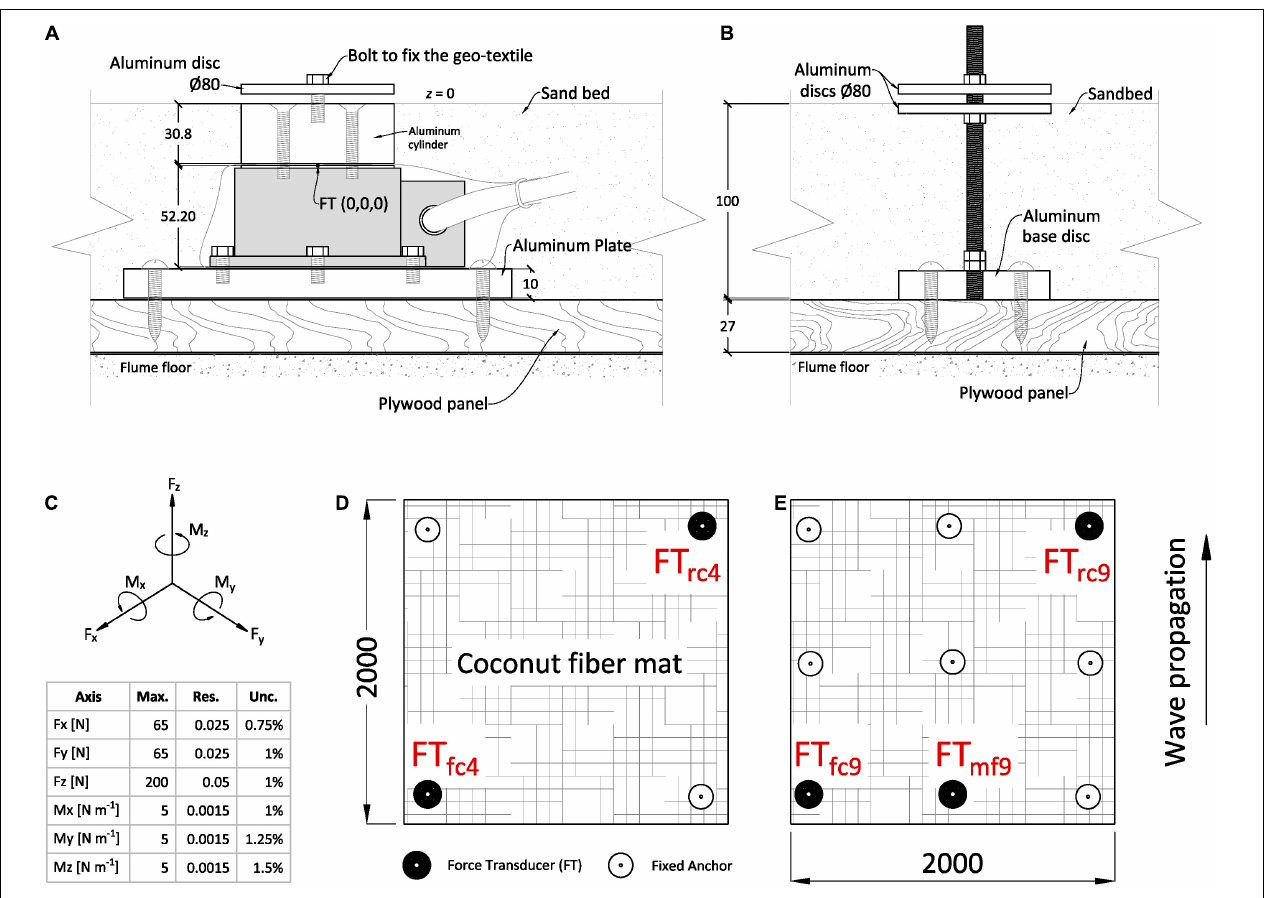
FIGURE 2 | Anchor set-up and positions. (A) Force-Torque transducer (FT), shown in gray, and its mounting frame which includes a custom-made aluminum cylinder to make the transducer flush with the sand bed. (B) Fixed anchor construction. (C) Schematic of the 6 degrees of freedom (DOFs) of the FT measured at (0,0,0) shown in panel (A) and device specifications (Res = resolution; Max. = measuring range; Unc. = uncertainty given by manufacturer). The axes directions were set to match the coordinate system used in the flume. (D) 4-anchor mat configuration and position of the FT for measurements, respectively, tagged. (E) 9-anchor configuration (only used for the experiments without artificial vegetation) with the different FT positions. Subscripts in panels (D,E) denote the specific anchor position and set-up as follows: f and r stand for front and rear, c and m for corner and middle, and 4 and 9 for the number of anchors, respectively. Note that the indicated wave propagation direction for panels (D,E) is down to up. All dimensions are given in